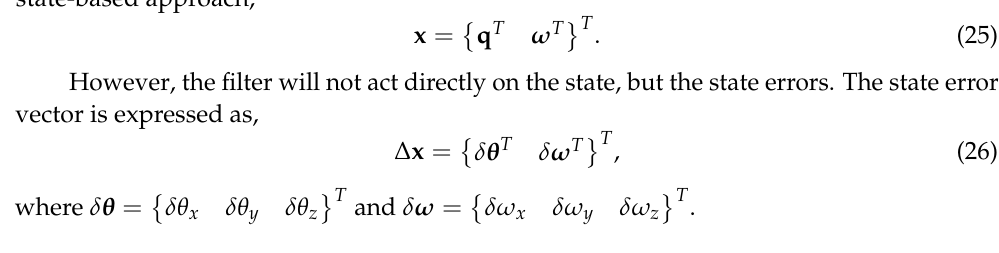
Table 1. EKF methodology for the Star Tracker only state-based